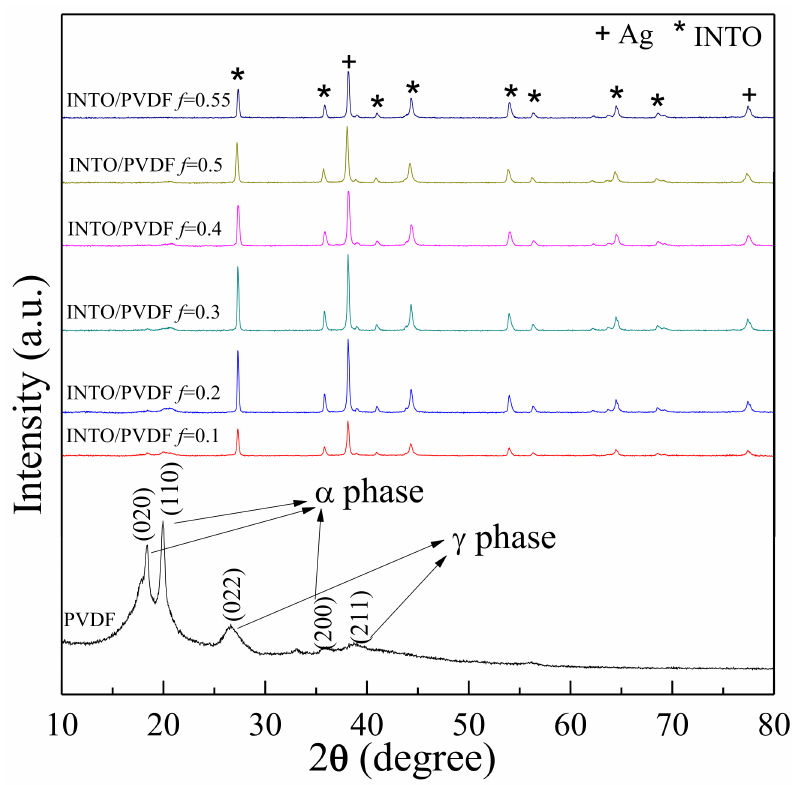
Figure 2. XRD patterns of pure PVDF and Ag − INTO/PVDF composites with various f Ag − INTO = 0 − 0.55.